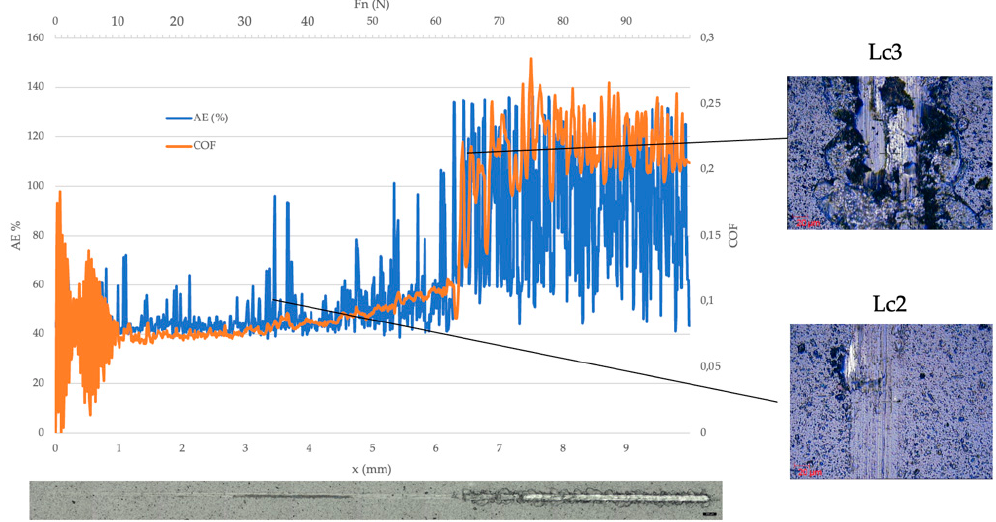
Figure 7. Scratch test results for the coated WC-TiC-Co samples. Evolution of the coefficient of friction (orange plot) and acoustic emission (blue plot) vs. the indenter displacement and the normal force, scratch obtained after the test and images of the zones of the track where critical loads Lc2 and Lc3 were recorded.